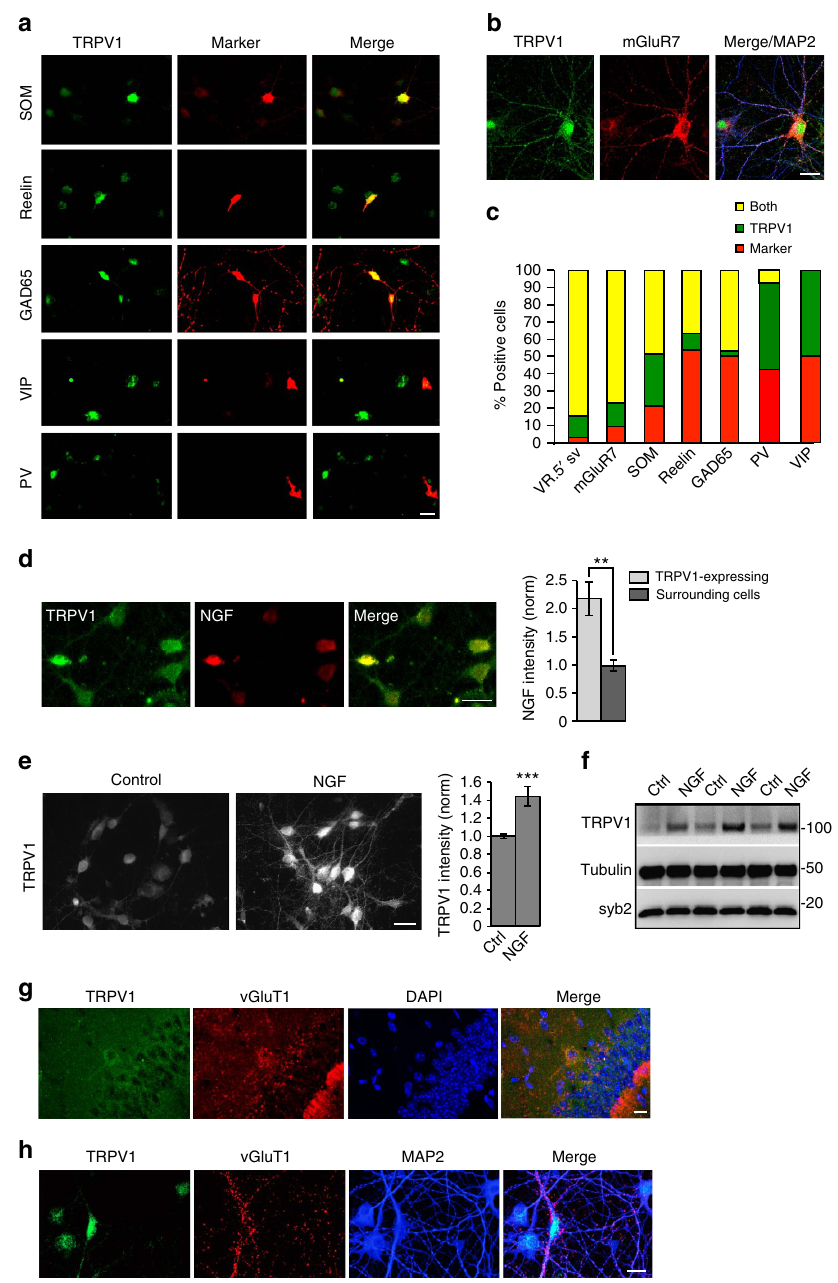
Figure 3 | TRPV1-expressing hippocampal neurons are positive for OLM neuron markers and NGF upregulates TRPV1. ( a ) Immunostains of hippocampal cultures for TRPV1 and Somatostatin (SOM), reelin, GAD65, VIP or Parvalbumin (PV). ( b ) Immunostain of hippocampal neuron culture for TRPV1, mGluR7 and MAP2; TRPV1-expressing neurons high mGluR7-positive innervation compared to surrounding neurons. ( c ) Quantitation of co-localization of immunofluorescence signal of different markers with TRPV1 neurons in hippocampal cultures. VR.5 0 sv quantification indicates signal from the C-terminal TRPV1 antibody, compared to the N-terminal TRPV1 antibody (Fig. 1e). Cells/images analysed: TRPV1/VR.5 0 sv n ¼ 54, TRPV1/mGluR7 n ¼ 22, TRPV1/somatostatin n ¼ 62, TRPV1/reelin n ¼ 52, TRPV1/GAD65 n ¼ 60, TRPV1/PV n ¼ 26, TRPV1/VIP n ¼ 22, from 3 to 6 cultures; scale bar, 20 m m. ( d ) Immunostain (left) and quantitation (right) of hippocampal cultures showing that NGF is highly expressed in TRPV1-expressing hippocampal neurons, compared to surrounding neurons ( n ¼ 15 images from three cultures; error ¼ s.e.m., significance determined by unpaired Student’s t -test with Welch’s correction, ** P o 0.01). ( e ) Images of control hippocampal neuron cultures and cultures treated with 1 ngml (cid:2) 1 NGFat DIV12–13 for 21–24h, immunostained for TRPV1 (left). Quantitation of TRPV1 immunofluorescence intensity normalized to control conditions is shown on the right ( n ¼ 26 (control), and 12 (NGF) from nine cultures; error ¼ s.e.m., significance determined by unpaired Student’s t -test with Welch’s correction, *** P o 0.001). ( f ) Western blot of TRPV1 in three repetitions of treatment of cultured hippocampal neurons with NGF compared to control. The levels of synaptobrevin-2 (used as a negative control) are unchanged. Tubulin serves as a load control. ( g ) Immunostain of a hippocampal section with TRPV1, vGluT1 and DAPI, showing high vGluT1 innervation of a TRPV1-expressing neuron in the stratum oriens; scale bar ¼ 20 m m. ( h ) Immunostain of a dissociated hippocampal neuron culture with TRPV1, vGluT1 and MAP2 (to mark neuronal cell bodies and processes), showing high vGluT1 innervation of a TRPV1-expressing neuron; scale bar, 20 m m.